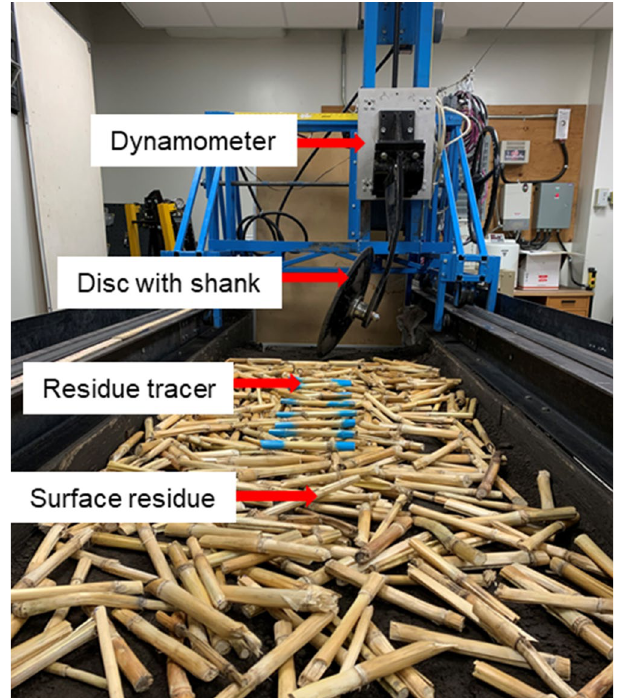
Figure 6. The testing facility showing the soil bin, corn residues prior to the test, a disc and shank mounted on the soil bin carriage through a